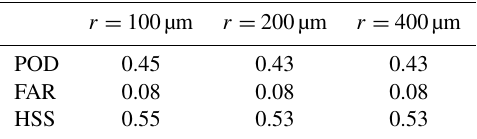
Table 6. Skill scores for comparison of MLC results of the non- seeding cases of the classification step 2 and the visual detection. The skill scores are calculated for the ice crystal sizes r = 100, 200 and 400µm. The values are rounded to two decimal